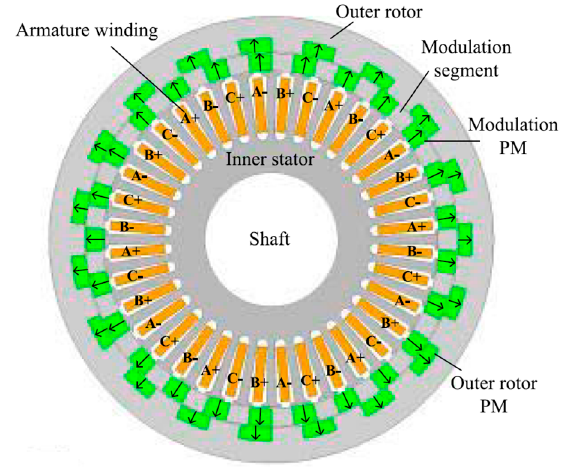
Figure 23. Configuration of a bidirectional FMPM machine [56].